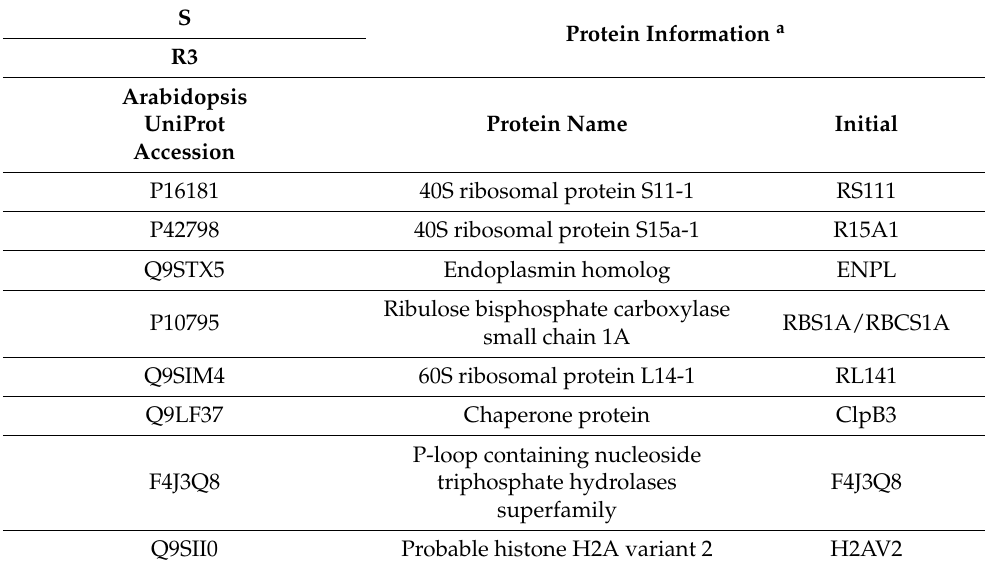
Table 4. Description of the optimum set of proteins ( S ) for R3 range